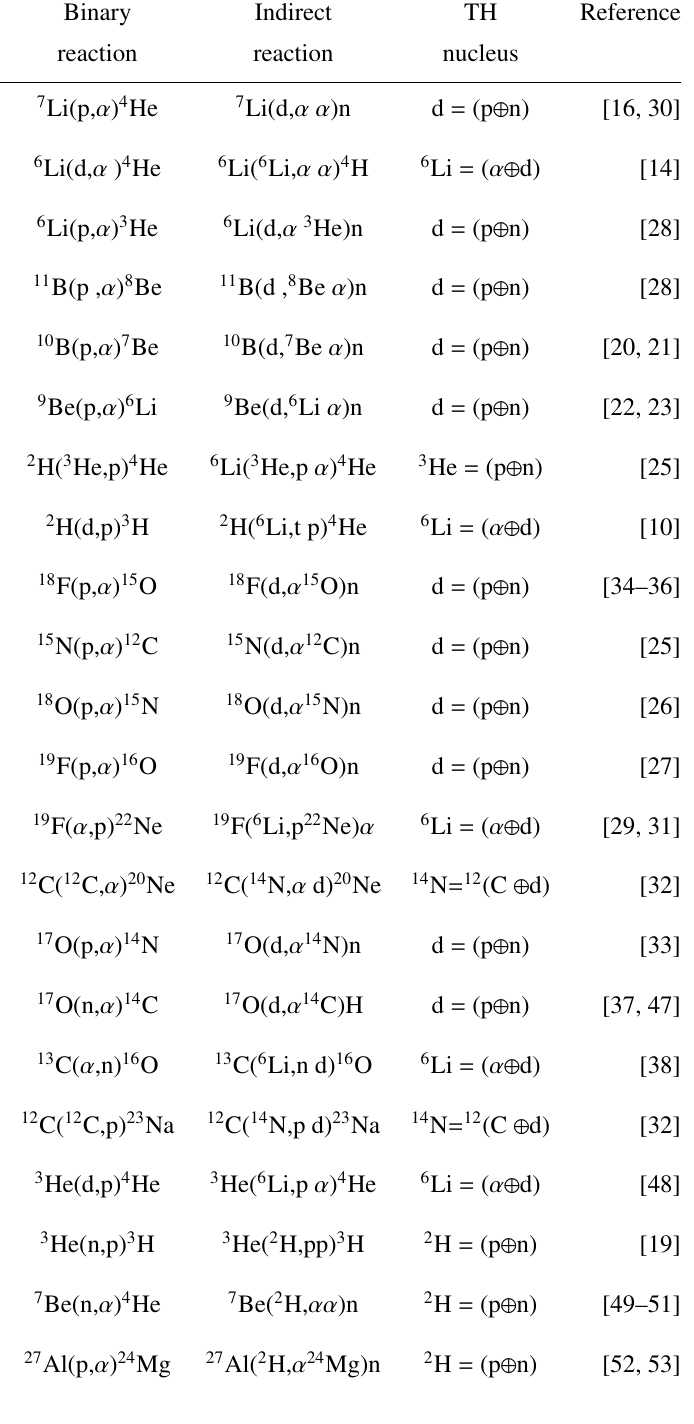
Table 1. Two-body reactions recently studied via Trojan Horse Method at the astrophysical